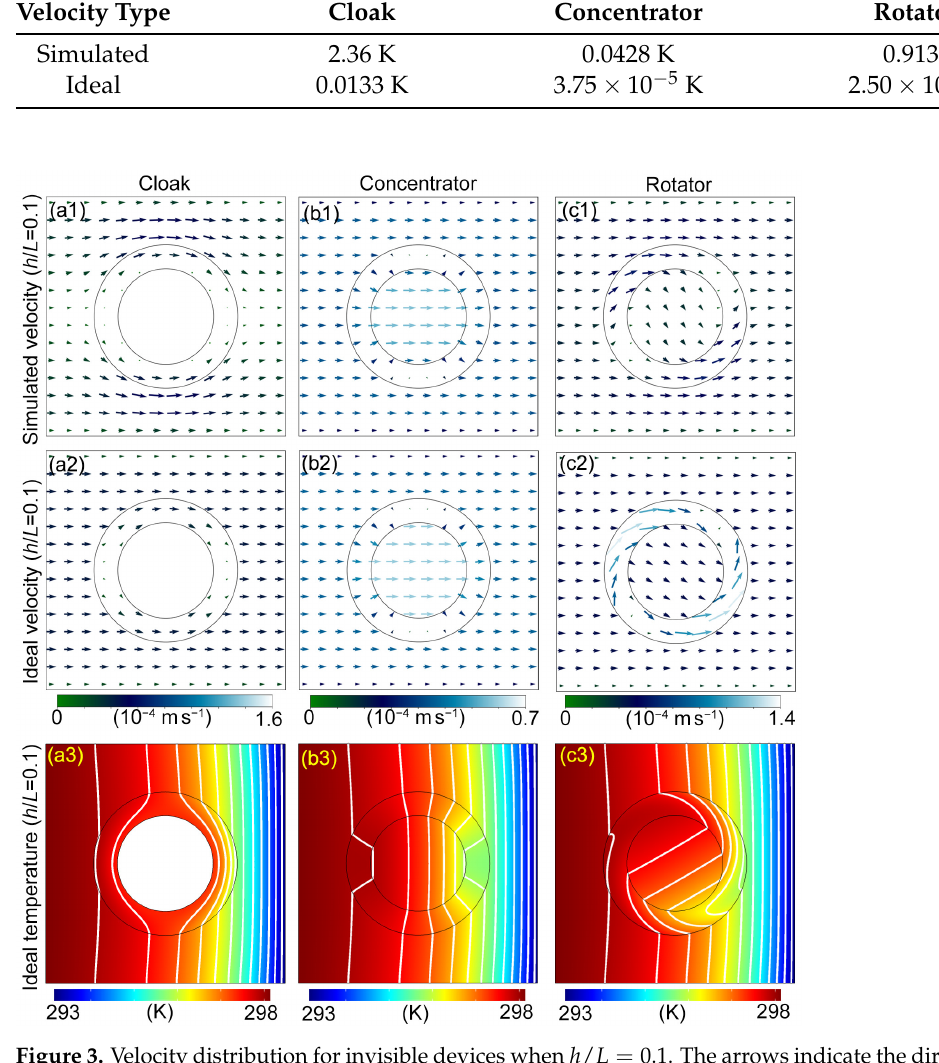
Figure 3. Velocity distribution for invisible devices when h / L = 0.1. The arrows indicate the direction of the velocity at their centers. The speeds are related to the lengths and colors of the arrows: ( a1 ) is the simulated velocity fields with regard to Figure 2(a3) (the cloak); ( a2 ) is the ideal velocity calculated from the transformation rule [Equation (3b)]; ( a3 ) is the simulated temperature distribution for the cloak under ideal velocity fields when h / L = 0.1; ( b1 – b3 ) or ( c1 – c3 ) are the same as ( a1 – a3 ) but for the concentrator or the